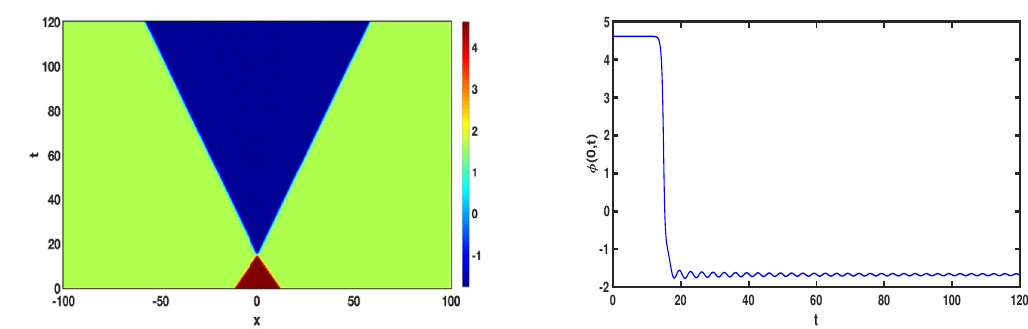
Figure 15 . Small kink-antikink collision, showing a) the changing of the topological sector and the production of a large antikink-kink pair. b) The scalar field profile at x = 0 showing the small oscillations after the collision. In both figures, r = 0 . 1 and v = 0 . 8.